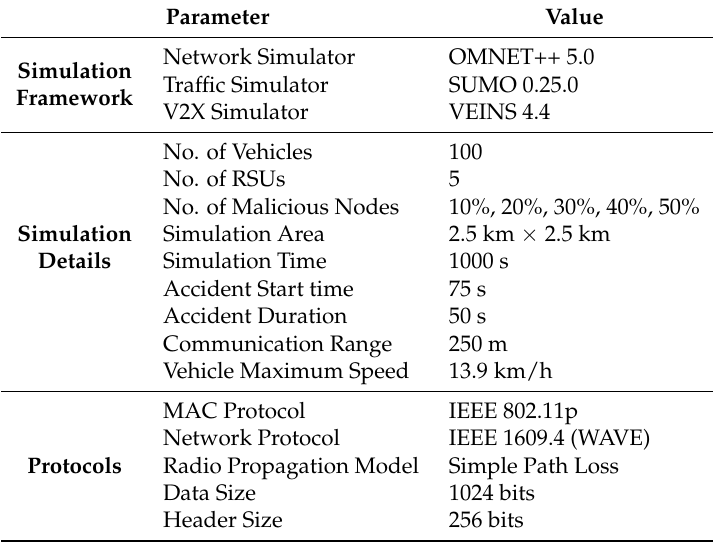
Figure 6. Snapshot of Veins ( a ) Vehicles during accident ( b ) Vehicles after accident. Table 2. Simulation